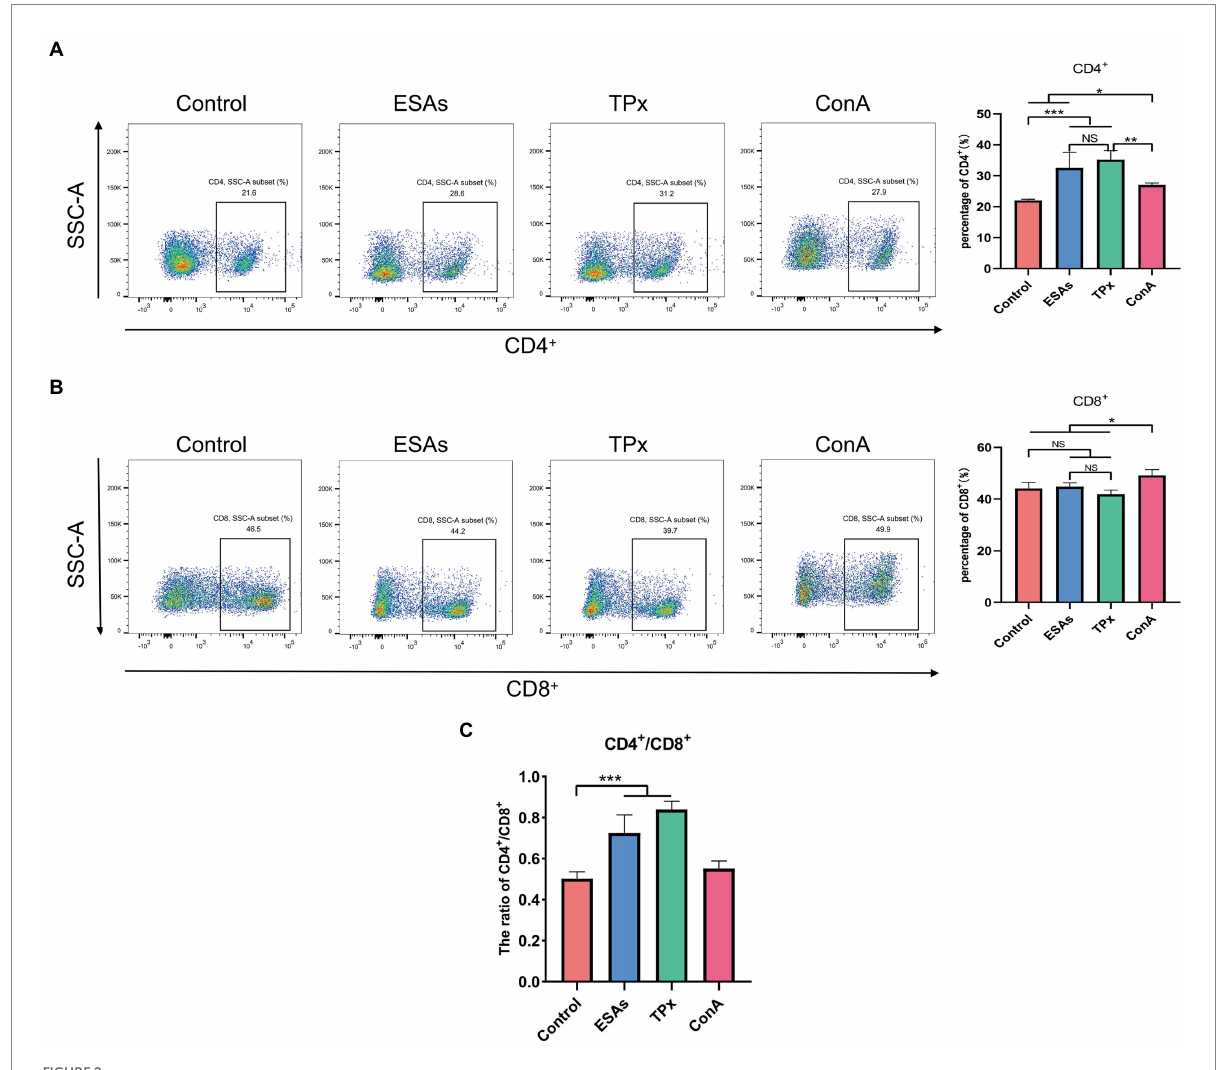
FIGURE 2 T-cell immune response assay. (A) Both Cysticercus cellulosae excretory-secretory antigens (ESAs) and TPx induced a significant increase in the number of CD4 + T lymphocytes. (B) Neither C. cellulosae ESAs nor TPx induced an increase in CD8 + T lymphocytes with statistical significance. (C) Both C. cellulosae ESAs and TPx induced a significant increase in the ratio of CD4 + /CD8 + T cells. All data were represented by means ± SD, NS stands for not significant, * p < 0.05, ** p < 0.01, *** p <